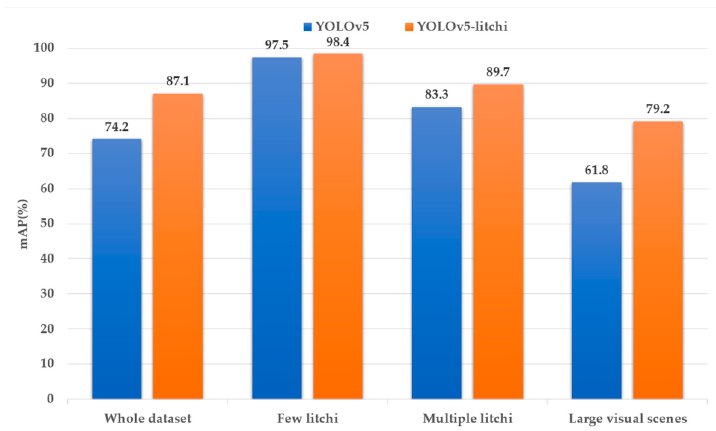
Figure 9. Comparison of different conditions.